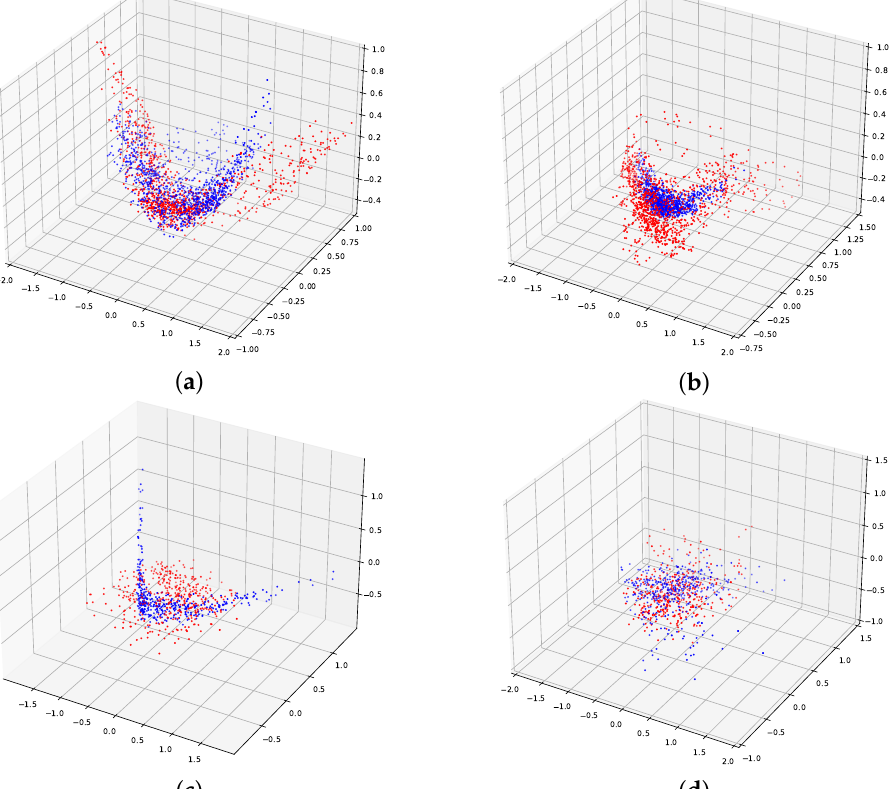
Figure 13. Comparison of feature distributions between the source and target data before and after adaptation. ( a ) Feature distribution of Water data before adaptation. ( b ) Feature distribution of water data after adaptation. ( c ) Feature distribution of Low-Density Urban data before adaptation. ( d ) Feature distribution of low-density urban data after